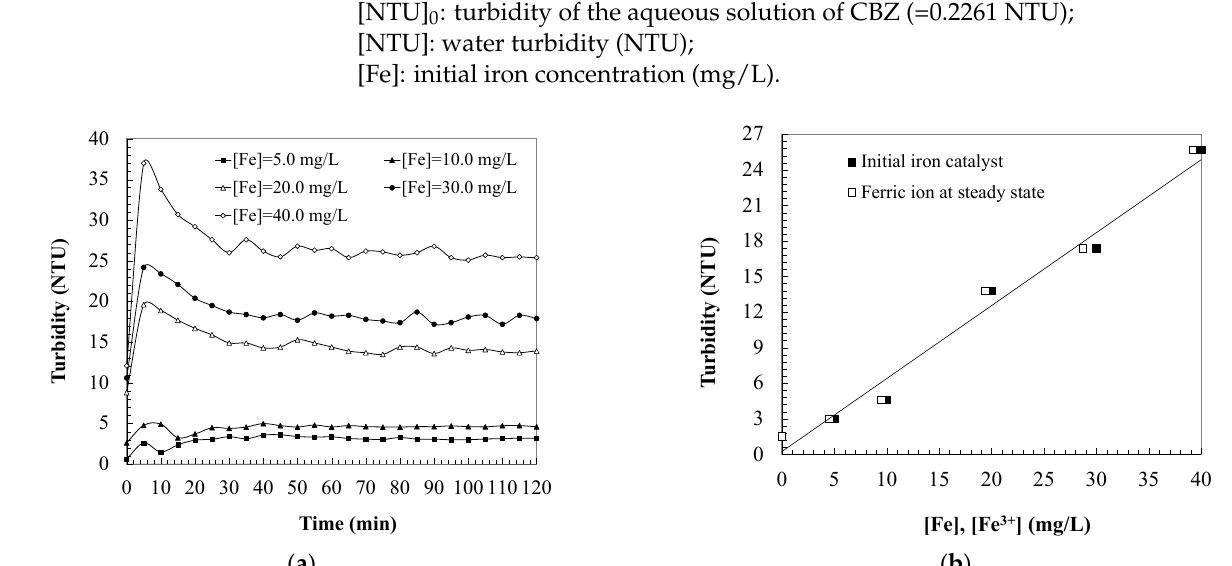
Figure 6. ( a ) Effect of iron catalyst on turbidity changes in a photo-Fenton system during the carbamazepine oxidation. ( b ) Effect of iron concentration on the solutions turbidity once the steady state is achieved. Experimental conditions: (CBZ) = 50.0 mg/L; pH = 3.0; (H 2 O 2 ) = 15.0 mM; (UV) = 150 W; T = 40 °C.